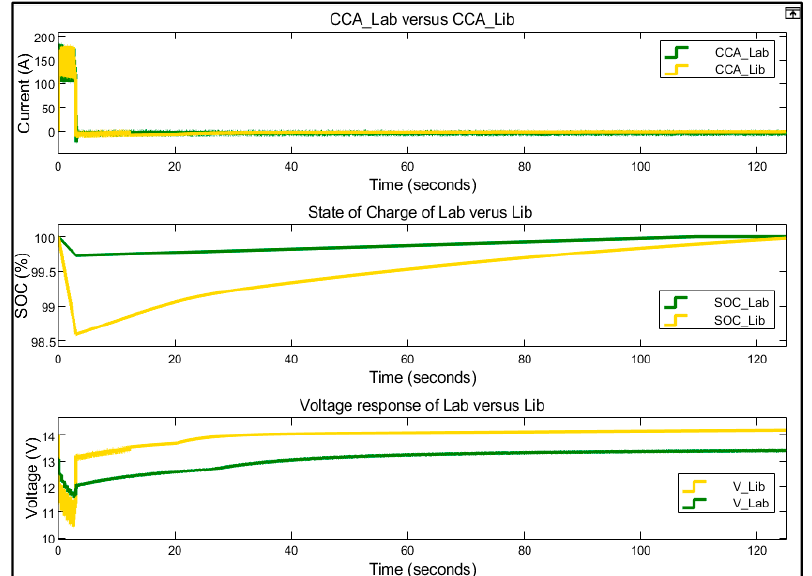
Figure 19. The percentage CCC, SoC and voltage response of hybridized ESSs during charging and discharging modes for case two.